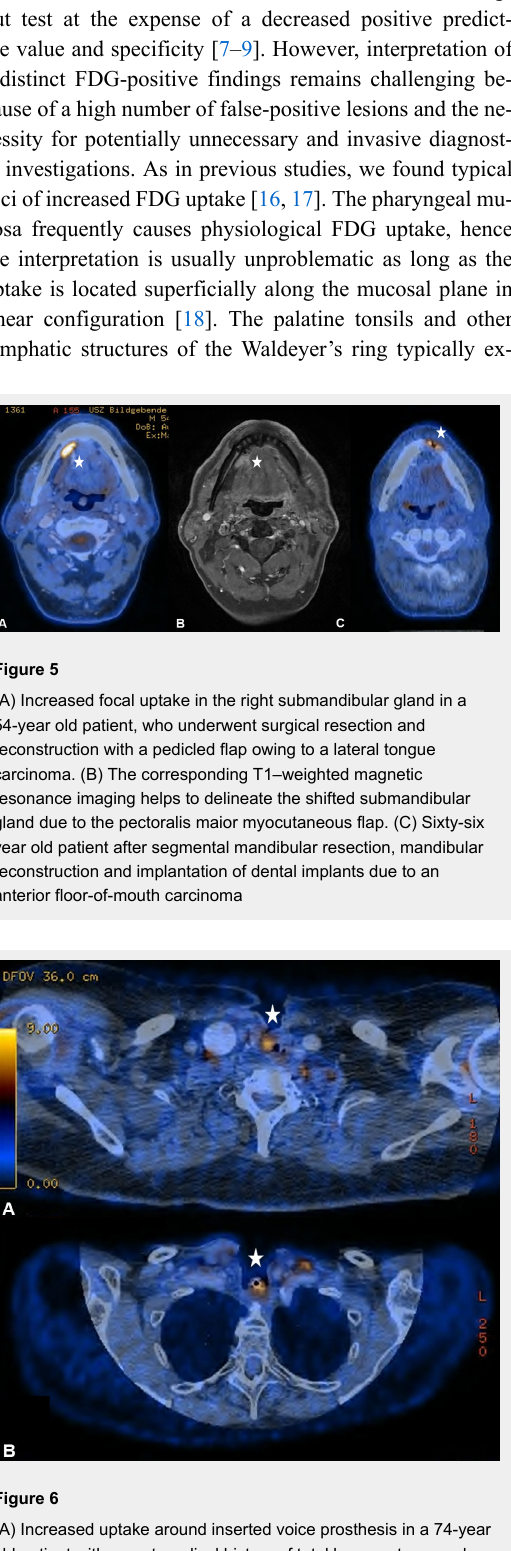
(A) Increased uptake around inserted voice prosthesis in a 74-year old patient with a past medical history of total laryngectomy and radiation therapy (RT) due to a transglottic larynx carcinoma. (B) Seventy-one year old patient after total laryngectomy, partial thyroidectomy and RT with increased uptake around the tracheostoma.